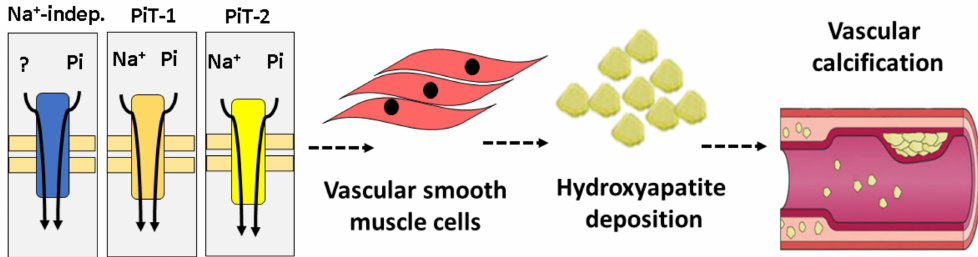
Figure 3. Schematic of the role of sodium-independent Pi transport in the development of vascular calcification (VC). Na + -independent and Na + -dependent Pi transport (PiT-1 and PiT-2) in vascular smooth muscle cells (VSMCs) contributes to hydroxyapatite deposition in these cells